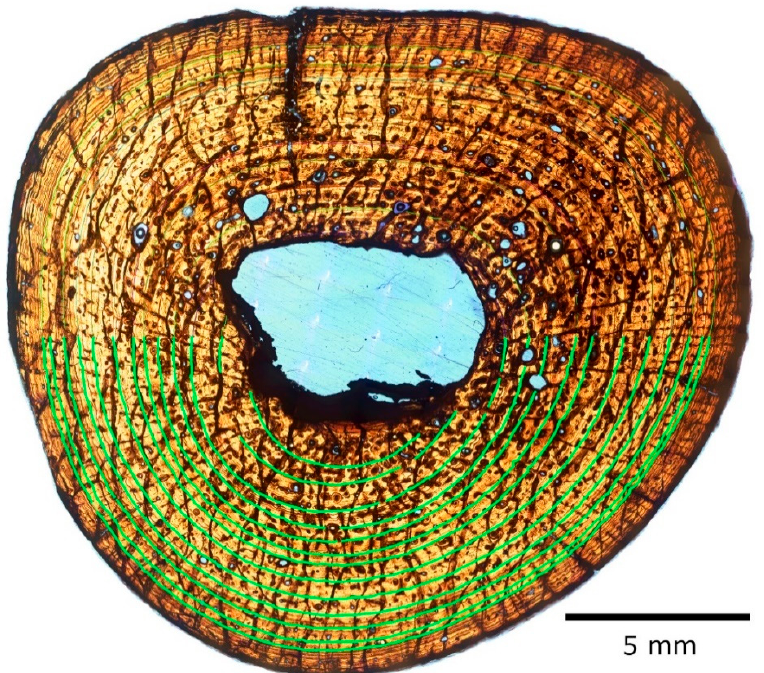
Figure 7. Right humerus of NJSM 23368, mid-diaphyseal transverse section, slide 1 under ordinary transmitted light. Thirteen CGMs are visible, enhanced for illustration here in the bottom (posterior) half of the image by tracing with green lines (brush size 50 pixels, hardness 100). The top (anterior) half has lines as traced for study (different colors per line, brush size 20 and hardness 50, which results in 10-pixel-wide lines at their core). Scale bar is 5 mm.